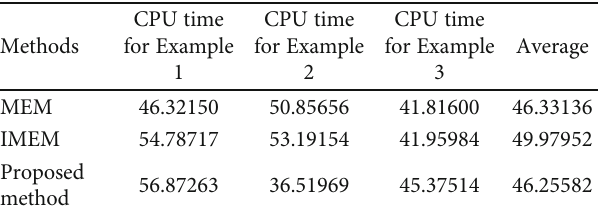
Table 8: CPU time (in seconds) for each example using the stated